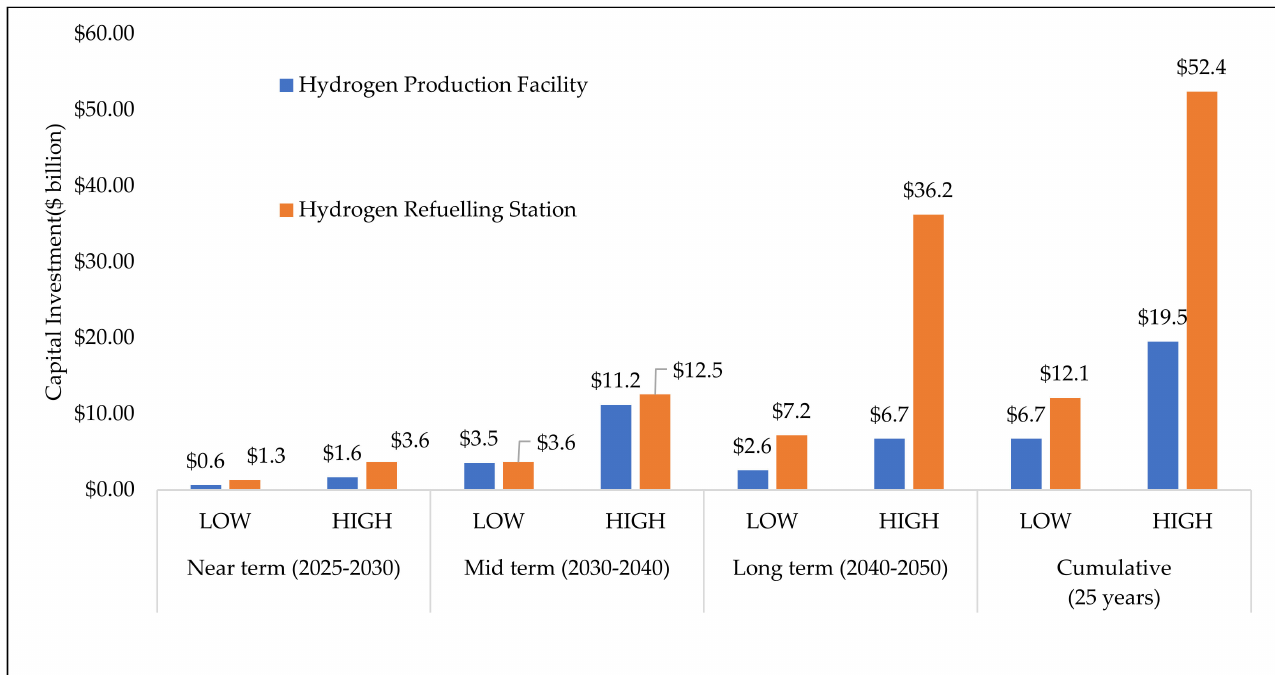
Figure 5. Overnight capital costs for build out of refueling stations and production